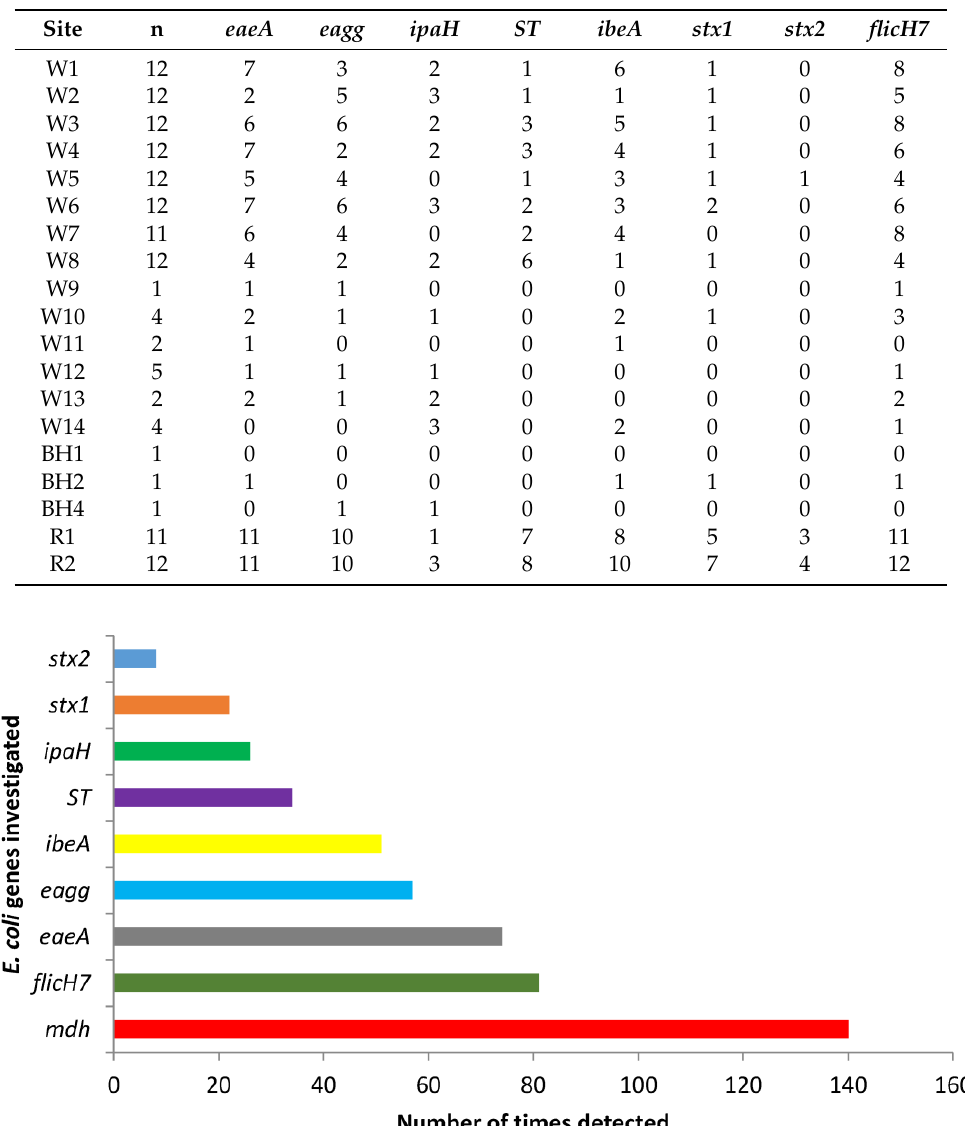
Table 3. Number of samples positive for each gene per sample site.